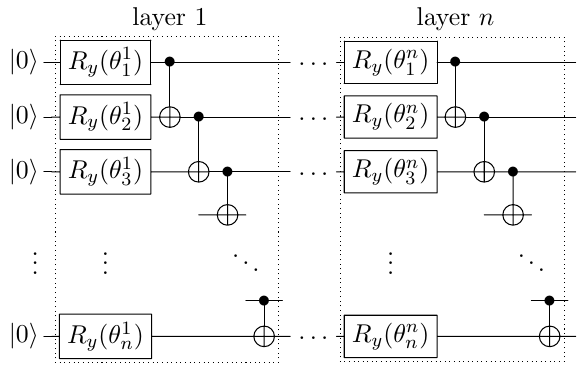
Figure 1. Schematic of the quantum circuit hardware-efficient Ansatz used in this